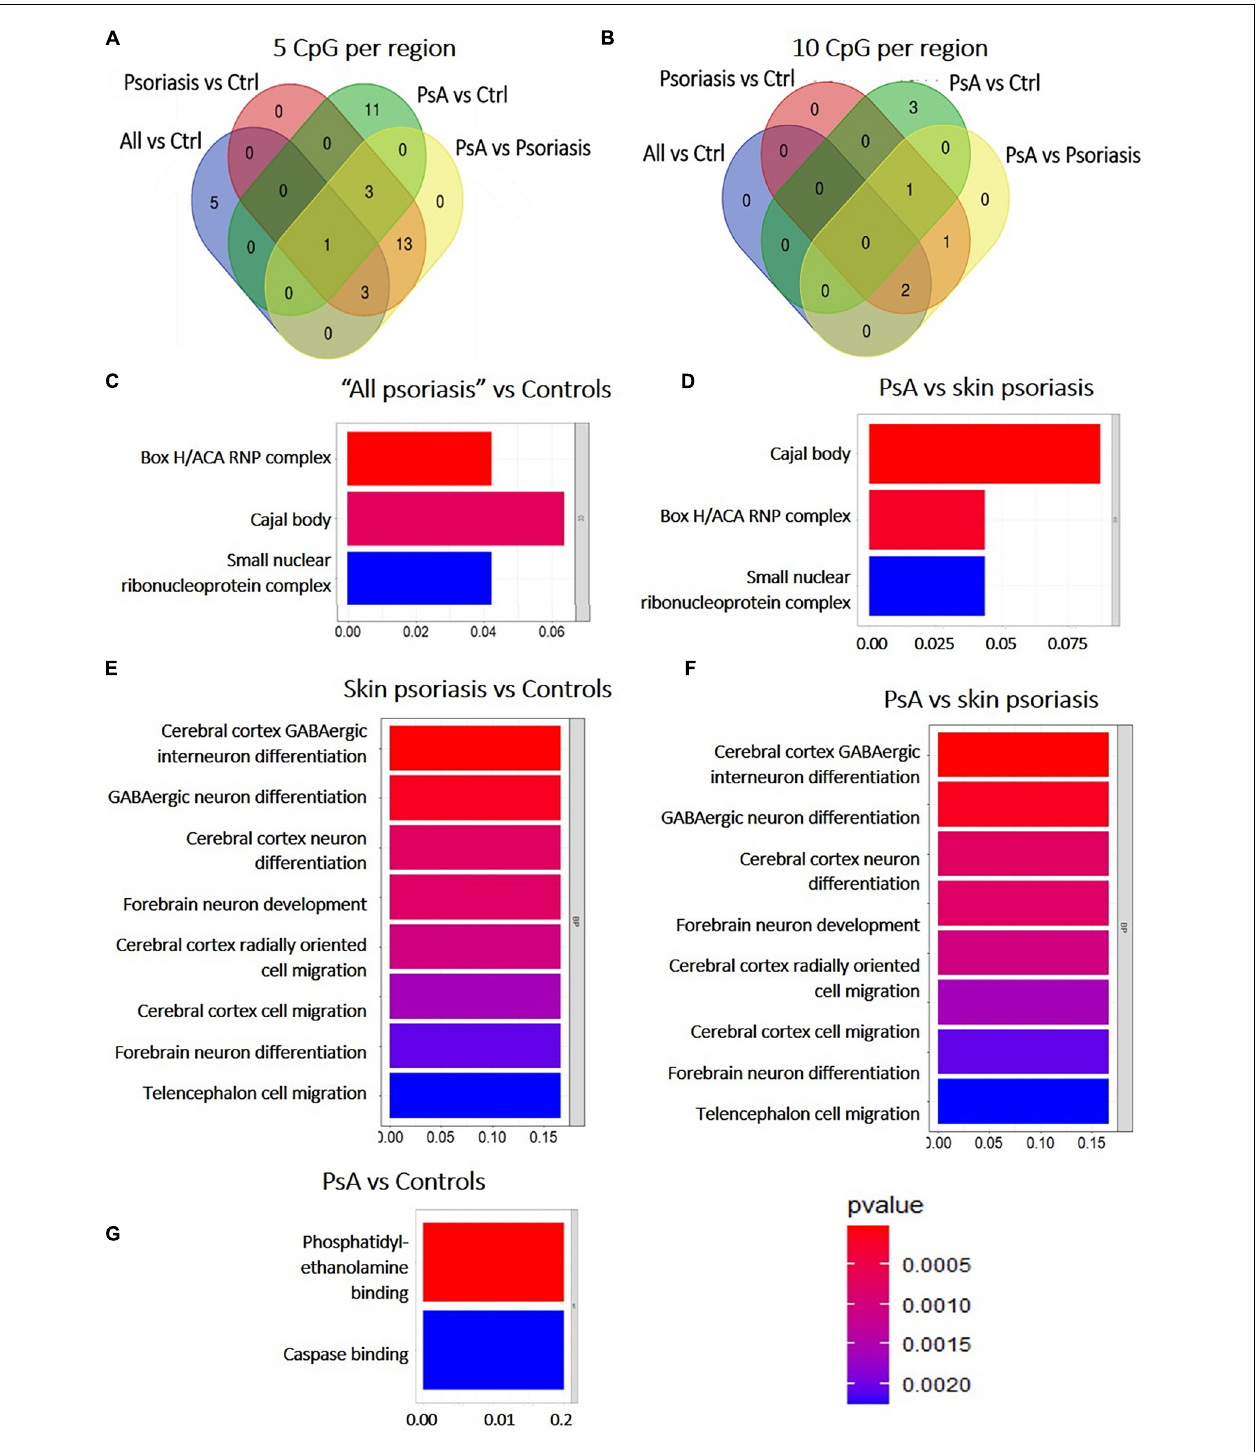
FIGURE 4 | Shared and unique Differentially Methylated Regions (DMRs) in CD8 + T cells from psoriasis patients and controls, and pathways affected. (A) Venn diagram showing overlapping and differentially methylated regions (DMRs) with ≥ 5 CpGs (A) and ≥ 10 CpGs (B) per regions, in “all patients” (all, including psoriasis and psoriatic arthritis patients) versus controls (ctrl), controls versus psoriasis, controls versus psoriatic arthritis (PsA), and psoriasis versus psoriatic arthritis. (C–G) The bar plot shows the results of the Gene Ontology (GO) analysis of genes associated with DMRs with ≥ 5 CpGs per region between “all patients” versus controls (C) and PsA versus skin psoriasis (D) ; and ≥ 10 CpGs for PsA versus skin psoriasis (F) , skin psoriasis versus controls (E) , and PsA versus controls (G) . Only significantly enriched terms for Biological Process (BP) and Cellular Component (CC) are represented ( P < 0.05).